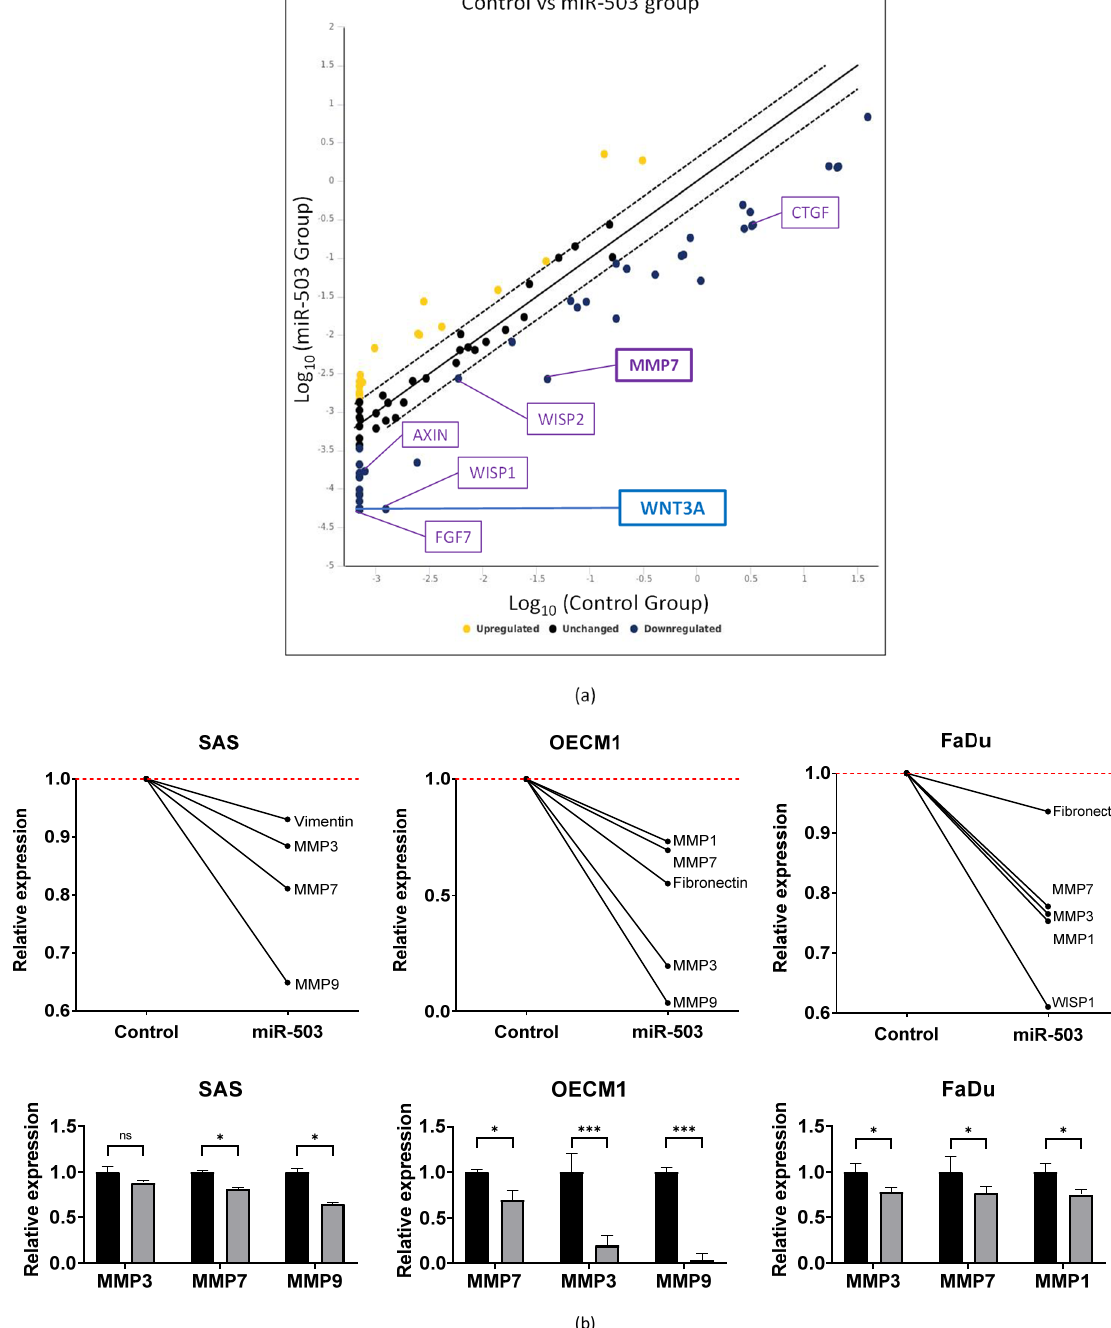
Figure 4. MiRNA-503 inhibits cell invasion through the WNT signaling pathway. ( a ) A PCR array was used to confirm the expression of WNT3A, as well as to search for targets associated with the WNT signaling pathway that may be deregulated by miR-503. ( a ) Scatter plot of the 84 genes in the array. An |FR| ≥ 2 threshold was used to separate the upregulated and downregulated genes. WNT3A was significantly downregulated, along with other important invasion genes such as MMP7, FGF7, and CTGF. ( b ) To determine the impact of invasion in HNC, a select list of genes commonly associated with cell motility was analyzed with RT-qPCR. Specifically, the expression levels of MMP family molecules were inhibited in the presence of miR-503, confirming the invasive function of miR-503 in HNC cells.The experiments were performed in triplicates. (* p ≤ 0.05, *** p ≤ 0.001, t -test, ns = not